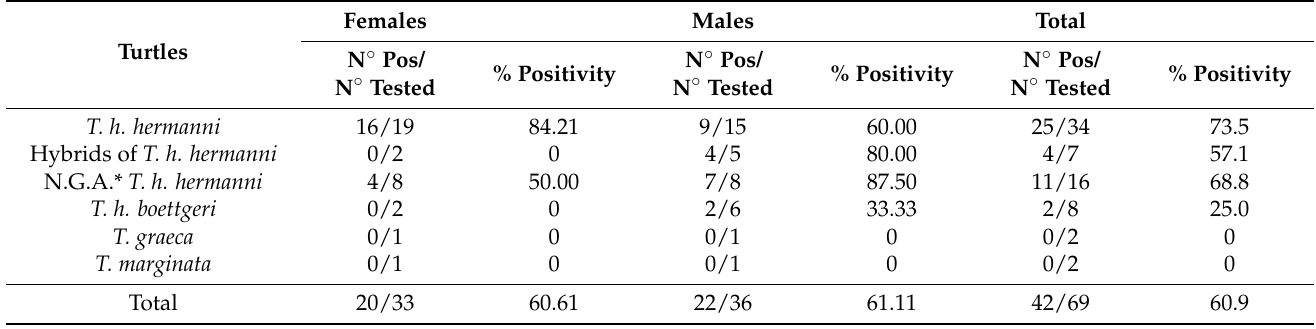
Table 1. Prevalence of Salmonella spp. in turtles housed in the rescue centre.